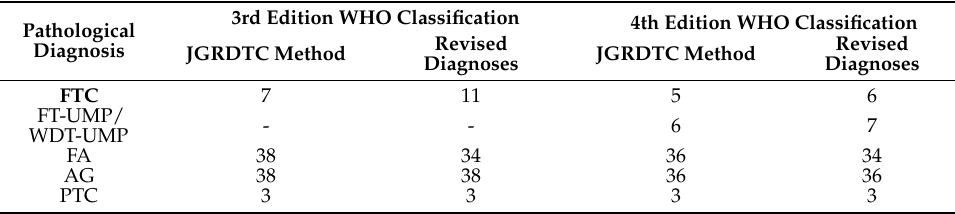
Table 3. Diagnoses of the 86 patients according to the 3rd and 4th edition of WHO classifications with JGRDTC method and revised pathological